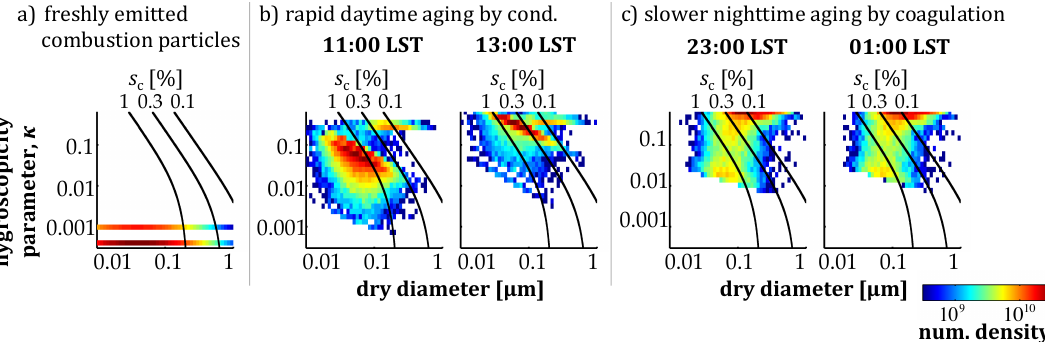
Figure 1. Two-dimensional probability density distribution shows changes in particle properties. As particles increase in size (horizontal axis) and hygroscopicity (vertical axis), they are able to activate at lower critical supersaturation thresholds (superimposed lines). (a) Freshly emitted particles are hydrophobic, with κ = 3 × 10 − 4 and κ = 8 × 10 − 4 for diesel and gasoline, respectively. (b) During the daytime, particles age rapidly by condensation of semivolatile substances that are produced through photochemical reactions. (c) At night, condensation aging is slow and particles age only by coagulation.